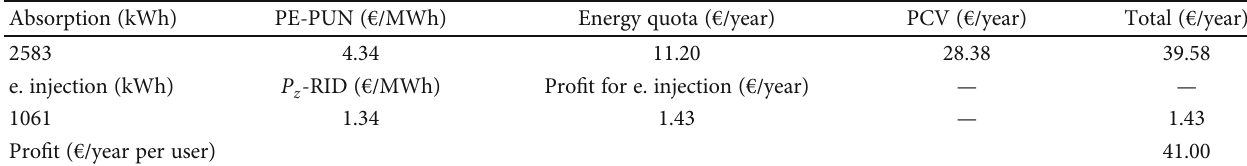
Table 4: Yearly CEP pro fi t for single end-user